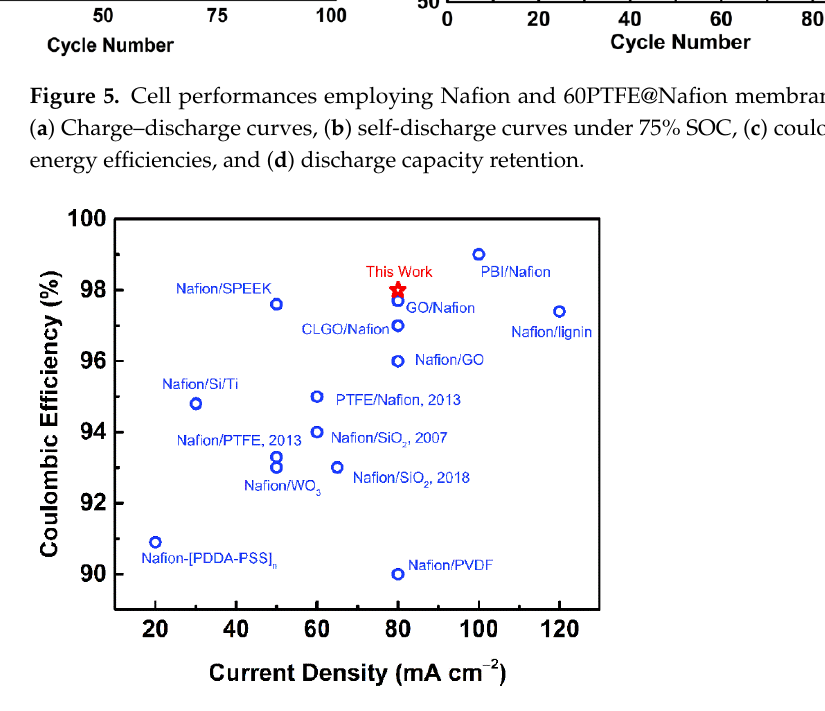
Figure 6. Comparison of coulombic efficiency for different Nafion-based membranes in VRFB at different current densities [16,20,27–38].